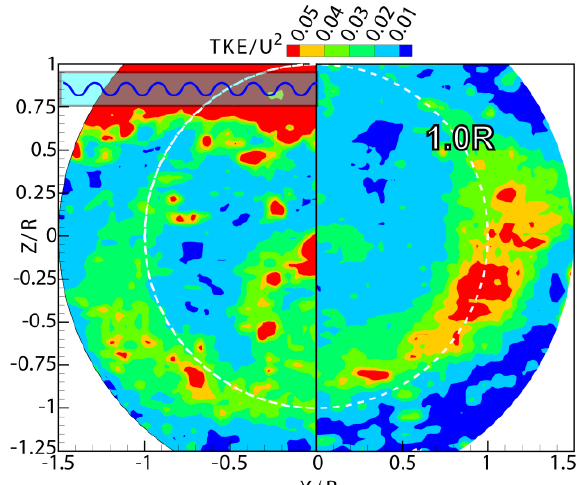
Figure 8. The turbulent kinetic energy (TKE) in the propeller region: Left . The ballast conditions; Right . The design condition.